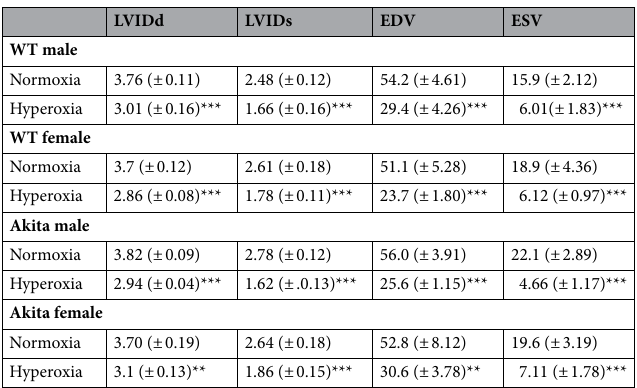
Table 1. Echocardiogram parameters after hyperoxia treatment. Values presented here are mean (n = 6 to 10 ± SEM ). **represents p < 0.005 and ***p <